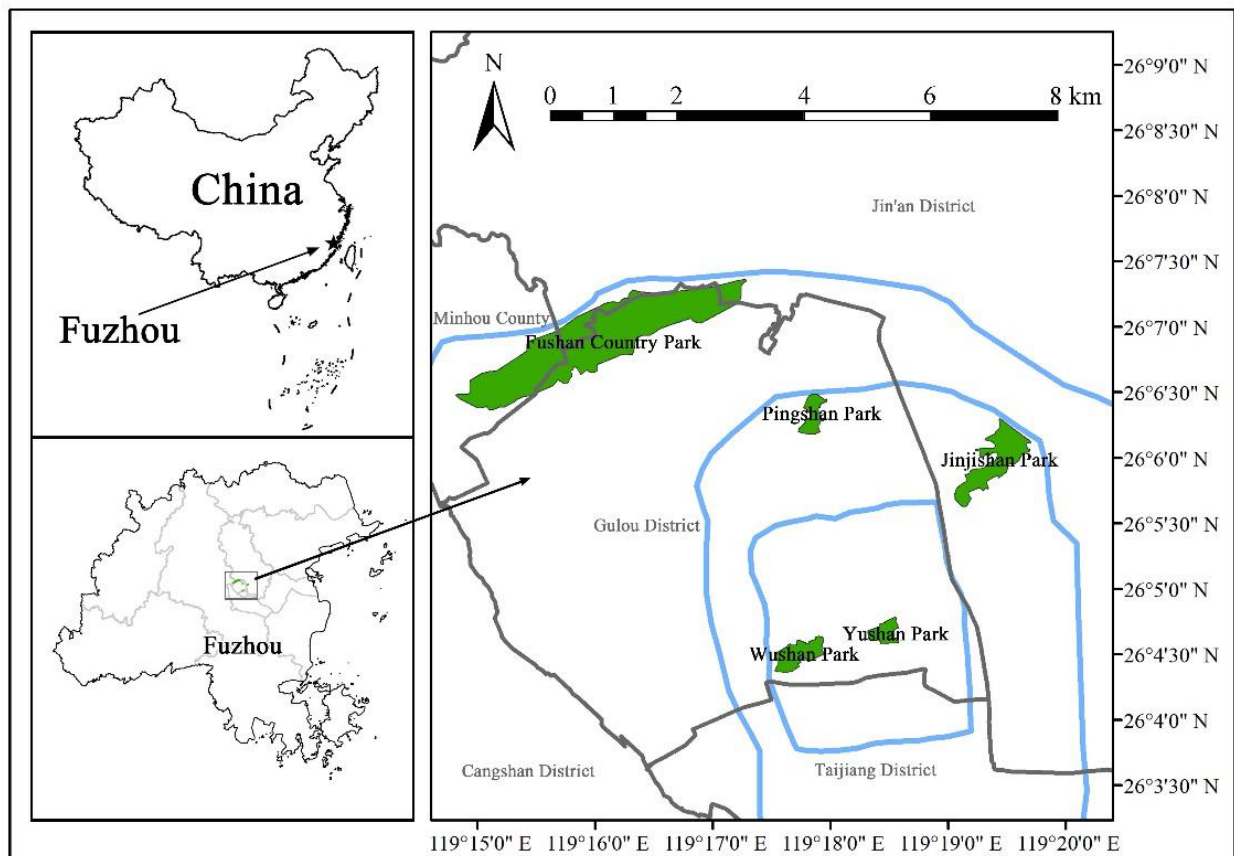
Figure 1. The location of the study area and the distribution of five urban mountain parks in Fuzhou city. The blue lines represent the Fuzhou high-speed ring road, which is the first ring, the second ring, and the third ring from the inside to the outside.